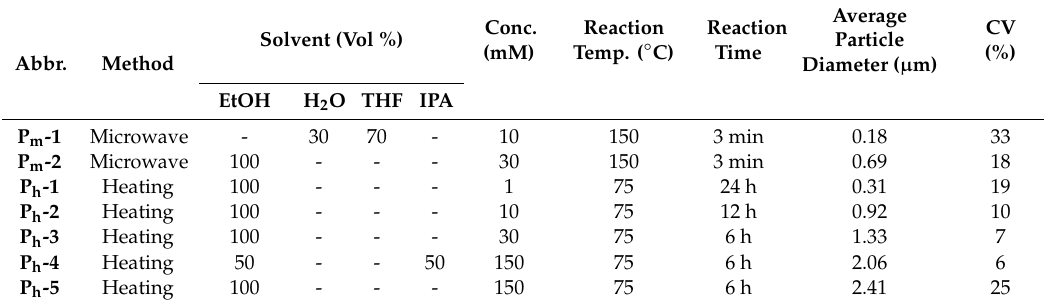
Table 1. Polymerization conditions and particle